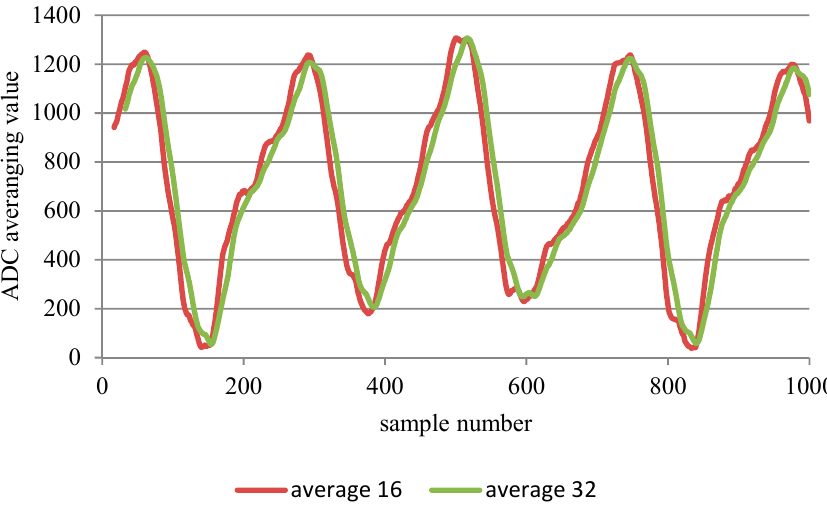
Figure 17. Averaging signal from 16 and 32 measures by LTC1407A.